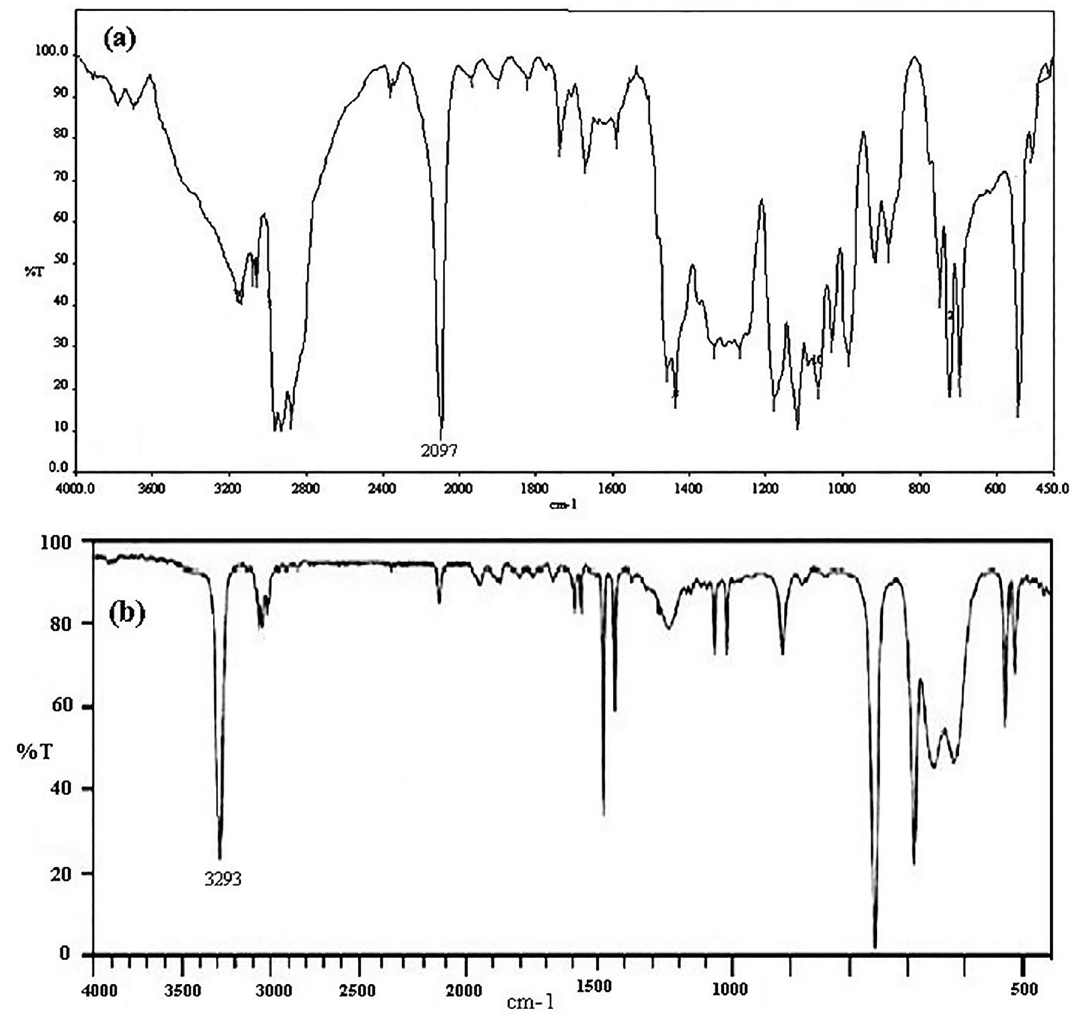
Figure 15. FT-IR spectra of ( a ) 2-azido-2-phenylethanthiol intermediate and ( b )